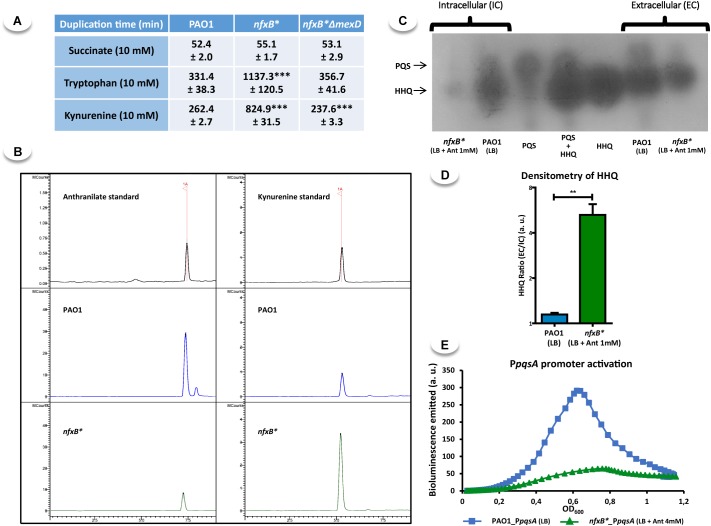
Impaired intracellular accumulation of anthranilate produced by an excessive kynurenine extrusion through MexCD-OprJ is not the cause for lower AQs production of the nfxB∗ mutant. Statistical significances were evaluated by using a Student’s two-tailed test and considered significant if P < 0.05, with a confidence interval of 95% (∗P < 0.05; ∗∗P < 0.01; ∗∗∗P < 0.001). (A) The duplication time of PAO1, nfxB∗, and nfxB∗ΔmexD strains growing in minimal medium with succinate (control), tryptophan or kynurenine (both anthranilate precursors) as sole carbon sources was determined. As shown, the nfxB∗ mutant presents an impaired growth in both tryptophan and kynurenine, and deletion of mexD gene restored the growth rate in nfxB∗ mutant, suggesting these compounds might be substrates of MexCD-OprJ. (B) Anthranilate and kynurenine accumulation in cell-free supernatants was quantified by HPLC-MS from PAO1 and nfxB∗ cultures grown along 24 h in M63 minimal medium with succinate (10 mM) and tryptophan (10 mM) as sole carbon sources. Left panels anthranilate, right panels kynurenine. As shown, the supernatants from nfxB∗ cultures contained more kynurenine and less anthranilate than those from the wild-type PAO1 strain, indicating that kynurenine is a substrate of MexCD-OprJ and anthranilate is not extruded by this efflux pump. (C) The production of AQs in PAO1 and nfxB∗ strains growing in LB medium supplemented with anthranilate 1 mM was analyzed in early stationary phase (OD600 = 2.5) by TLC. (D) The extracellular vs. intracellular HHQ ratios were calculated measuring each one of the HHQ spots obtained in the TLC-assays by densitometry. (E) Real-time pqsABCDE expression was analyzed in both PAO1 and nfxB∗ strains growing in LB medium and LB supplemented with anthranilate 4 mM respectively, using a chromosomal insertion of the reporter construction PpqsA::luxCDABE. The results show that anthranilate supplementation of LB medium does not restore the AQs production in the nfxB∗ strain (C,E), reinforcing our hypothesis that HHQ extrusion (D) rather than kynurenine extrusion through MexCD-OprJ is the main cause for the QS-defective response of the nfxB∗ strain.